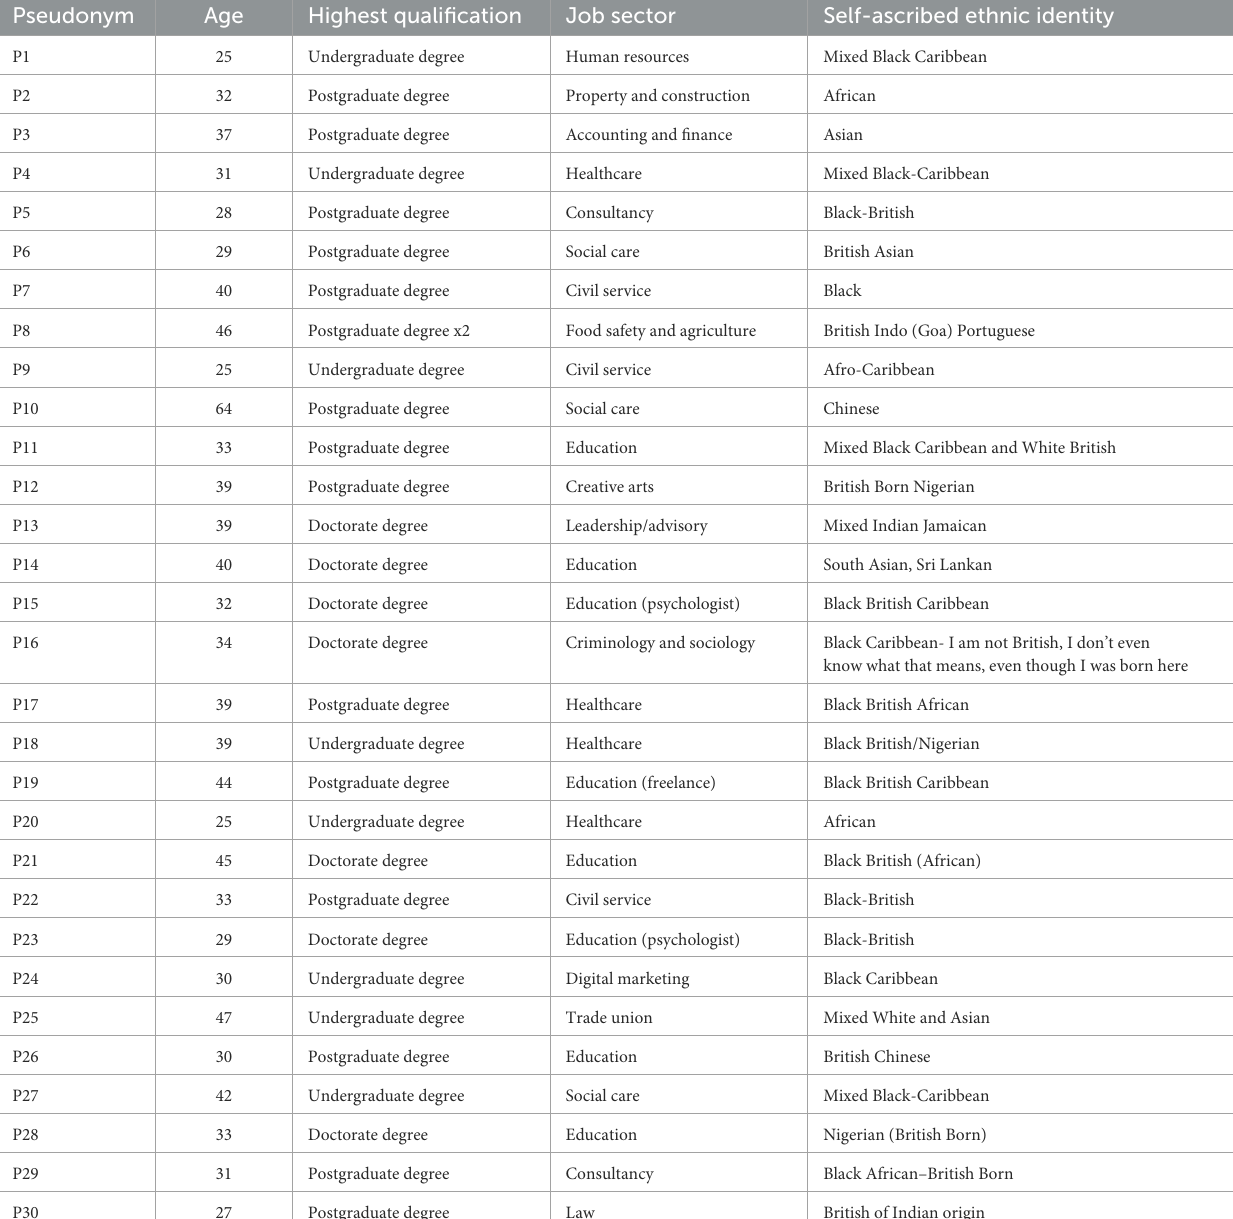
TABLE 1 Biographical data of